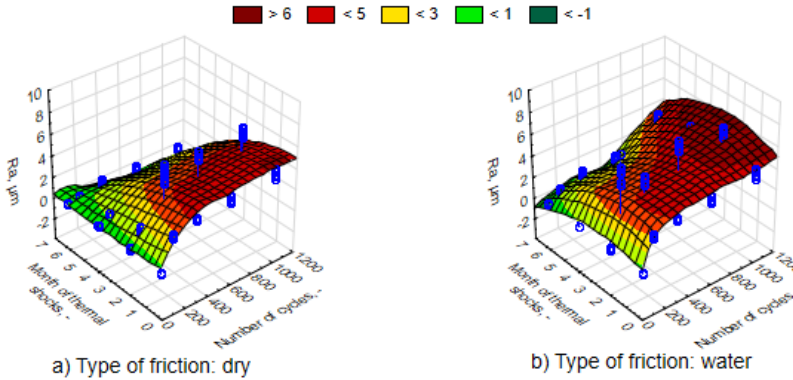
Figure 16. Characteristics of changes in the parameter Ra, depending on the number of friction cycles, for samples exposed to thermal shocks, ( a ) dry friction, ( b ) wet friction.